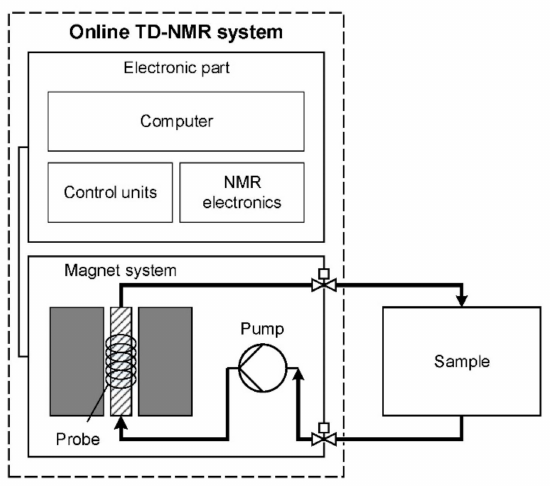
Figure 1. Schematic overview of the online time-domain nuclear magnetic resonance (TD-NMR) measuring